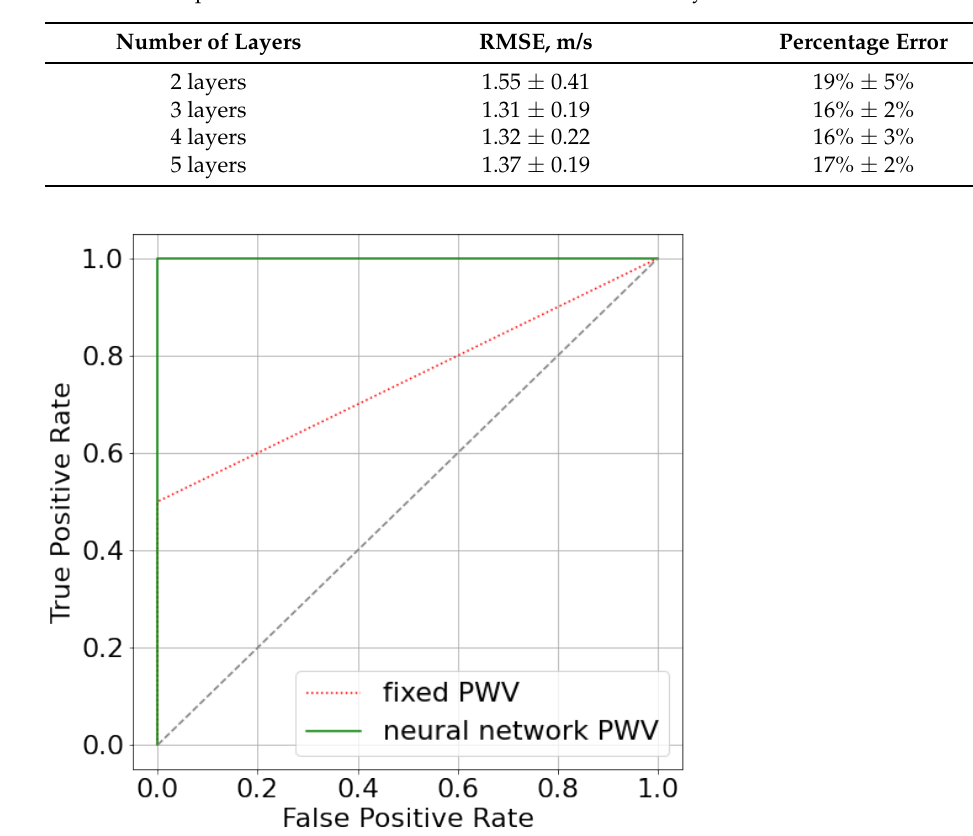
Figure A1. Activation functions of neural network (Figure 2). ReLU: y ( x ) = x if x ≥ 0 and y ( x ) = 0 if x < 0 . ELU: y ( x ) = x if x ≥ 0 and y ( x ) = e x − 1 if x < 0. Linear: y ( x ) = x . Table A1. Comparison of errors for various numbers of hidden layers in the neural network.